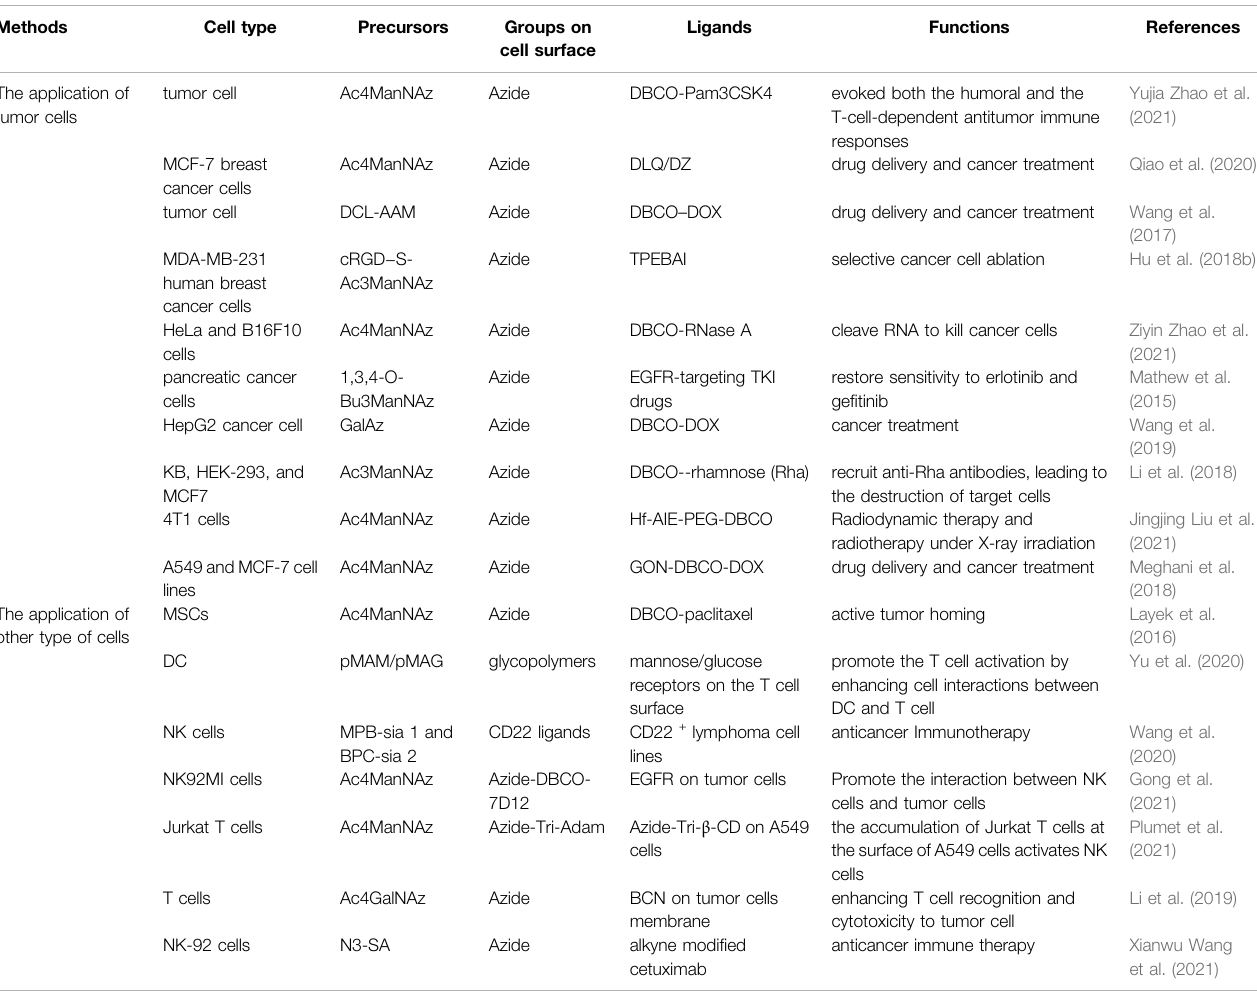
TABLE 3 | Metabolic glycoengineered cells for cancer treatment.